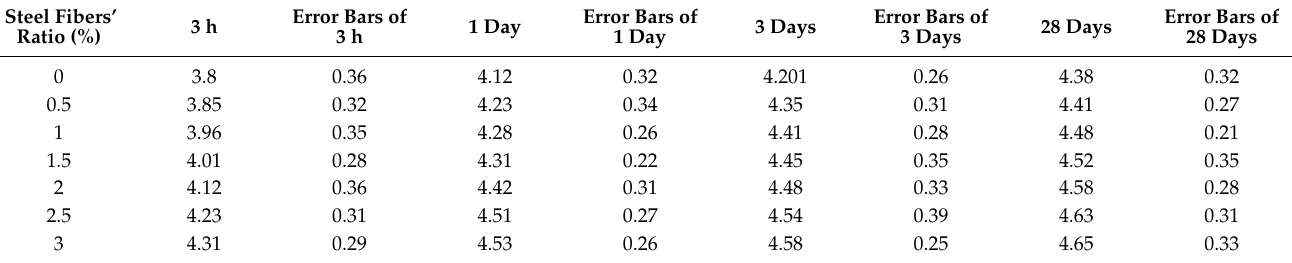
Table A4. The ultrasonic velocity of MPC-RPC